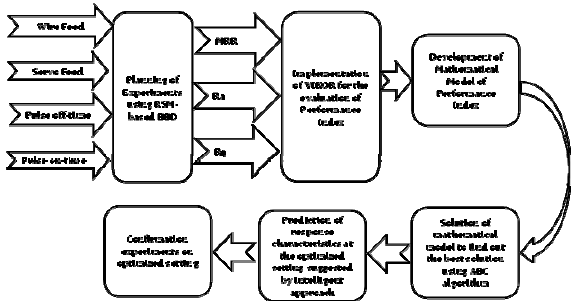
Figure 3. Methodology adopted in the present work